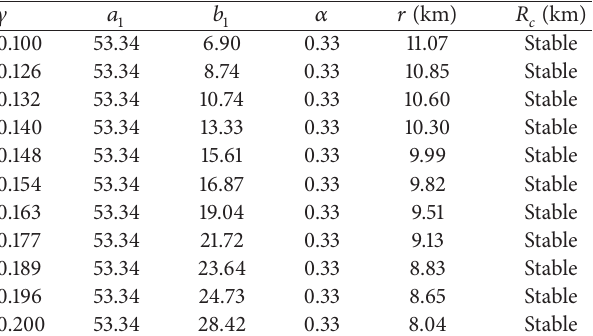
Table 1: Stability of neutral PSR J1614-2230 when 𝛾 and 𝑏 1 are variable.